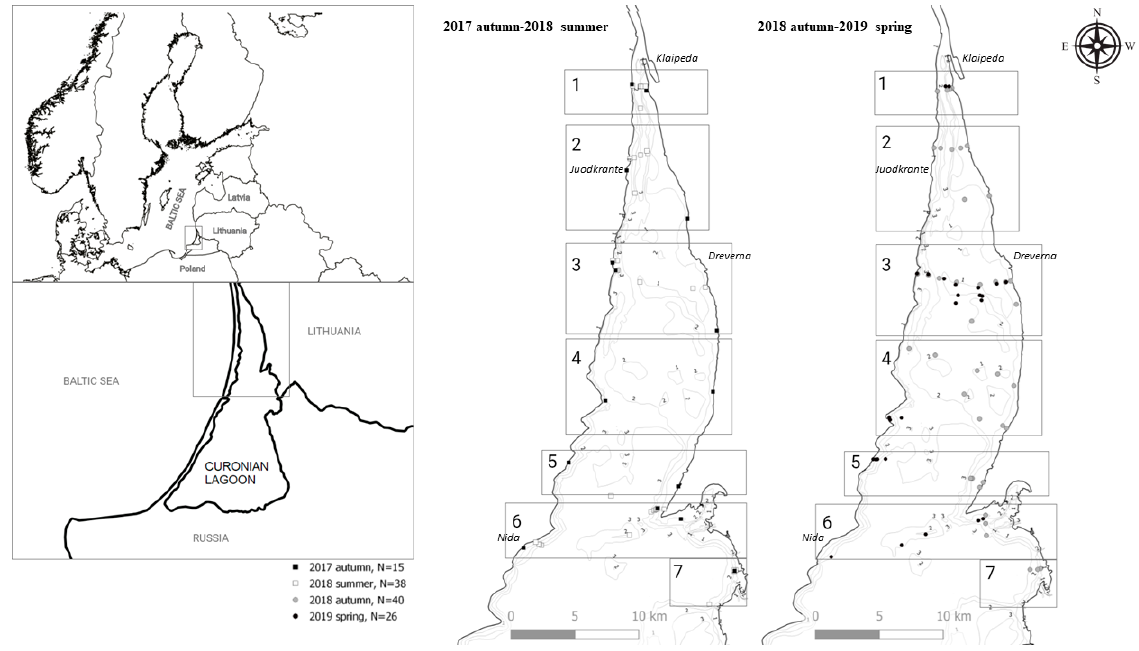
Figure 1. The study area with the sampling sites (indicated by symbols) and profiles (indicated by squares with numbers) in the Curonian Lagoon for the period of 2017–2019. N—number of the study sites.